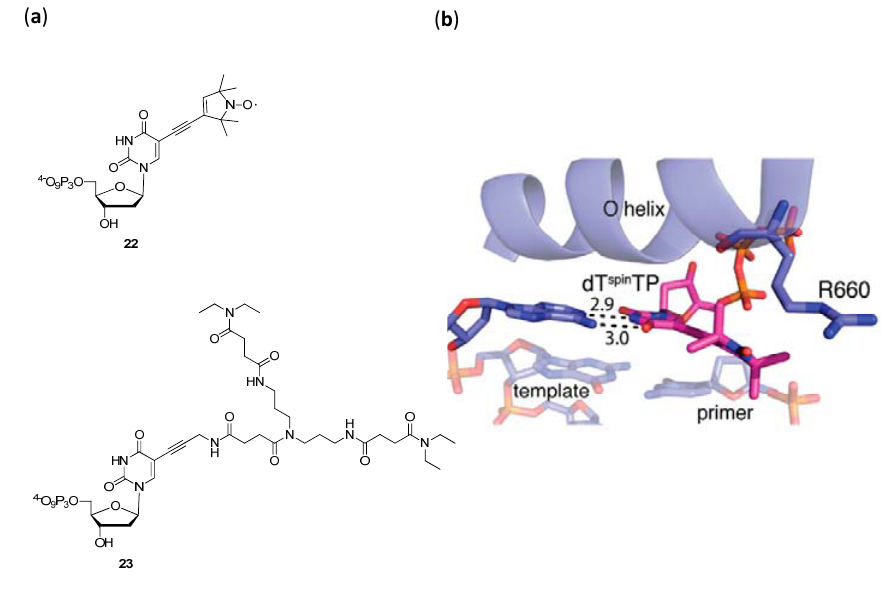
Figure 3. ( a ) Chemical structures of dT spin TP 22 and dT dend TP 23 ; ( b ) Close-up view of the X-ray structure of the DNA polymerase KlenTaq with the modified triphosphate dT spin TP 22 , picture taken from reference